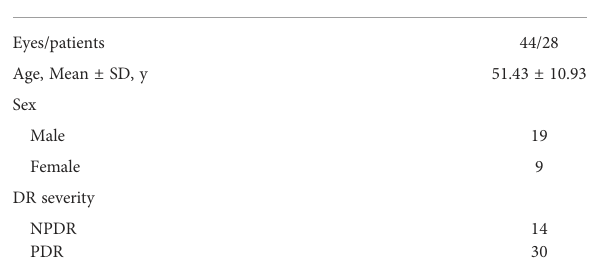
TABLE 1 Clinical